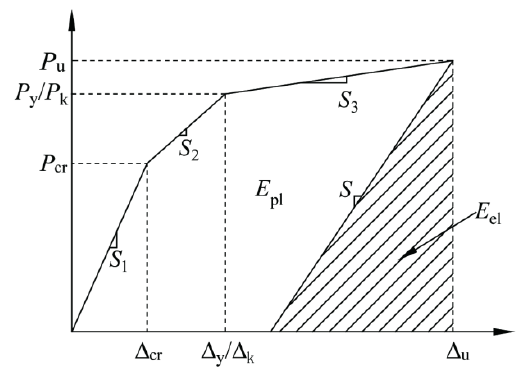
Figure 11. Schematic description of ductility